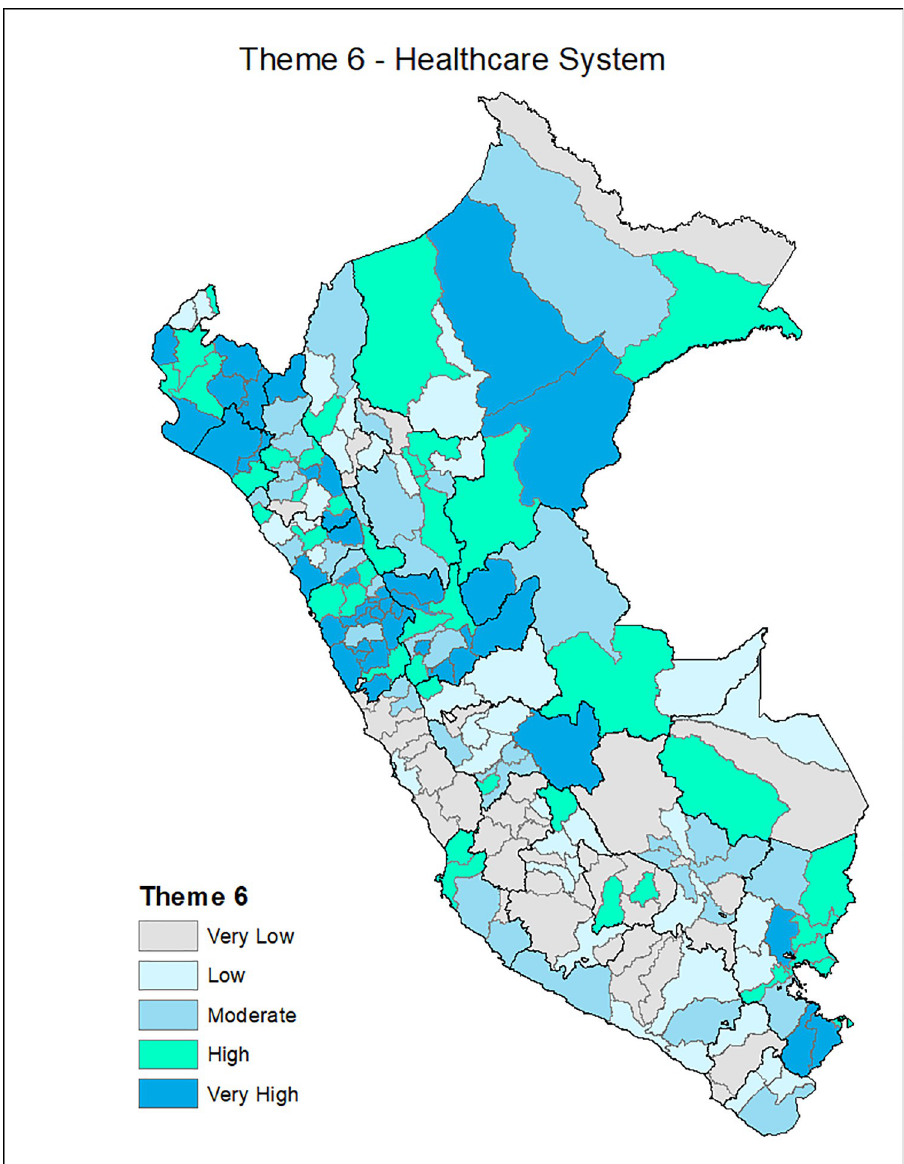
Fig 7. SVI topic 6: Healthcare